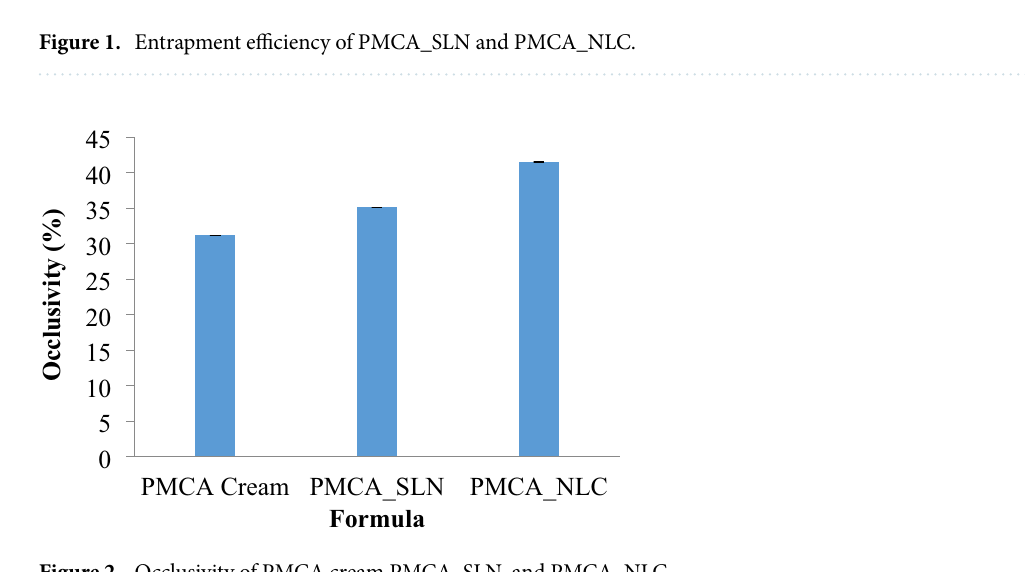
Figure 2. Occlusivity of PMCA cream PMCA_SLN, and